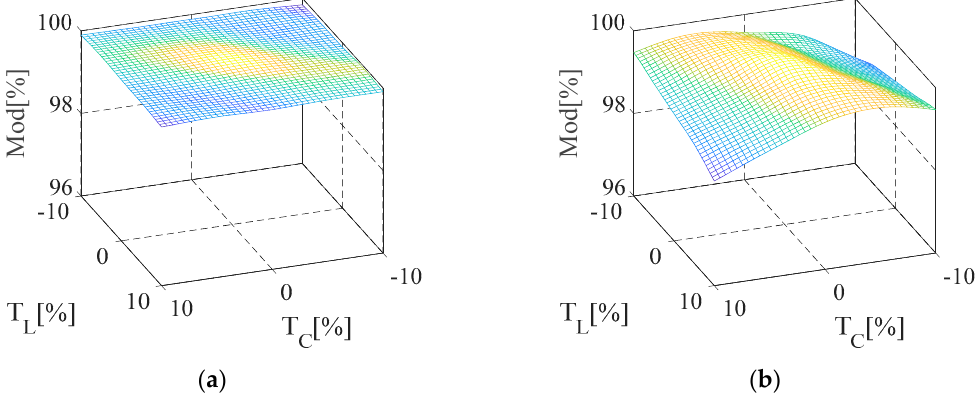
Figure 14. Variation of fundamental frequency dc-link current ripple magnitude (pu) with SM capacitance tolerances T C and arm inductor tolerances T L : ( a ) Scheme-A, and ( b ) Scheme-B.